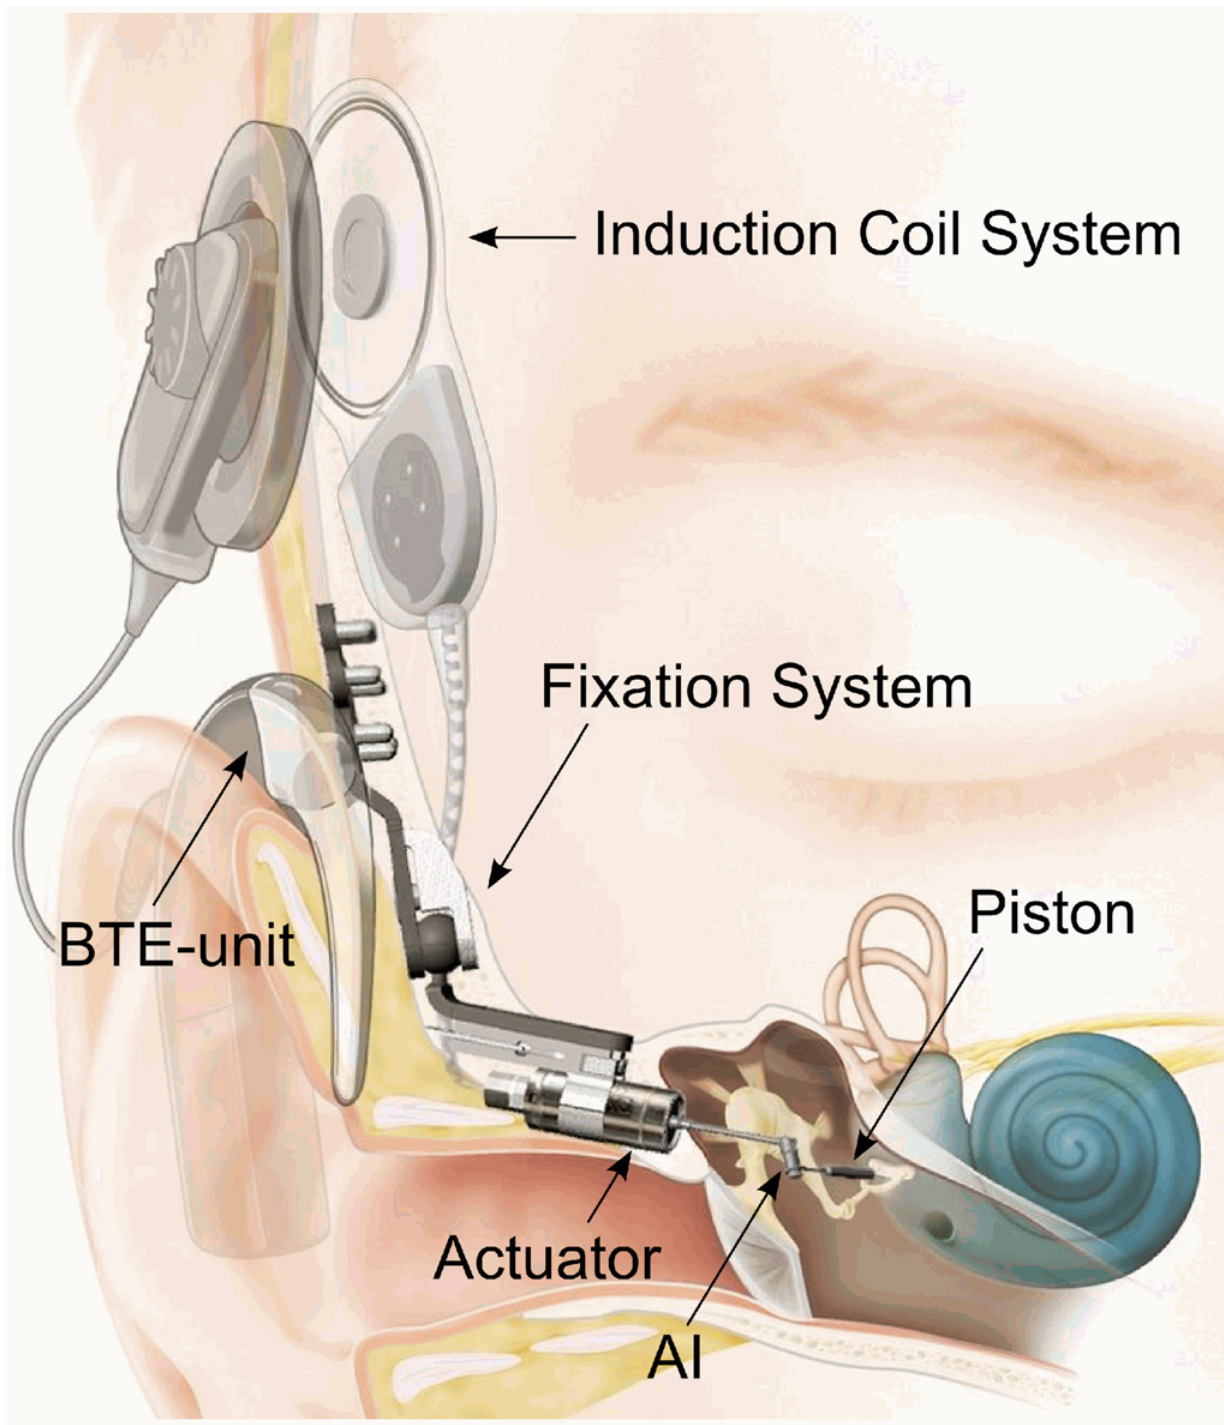
Fig 1. Illustration of the implanted Codacs system. (CC-BY by courtesy of Cochlear Ltd.).